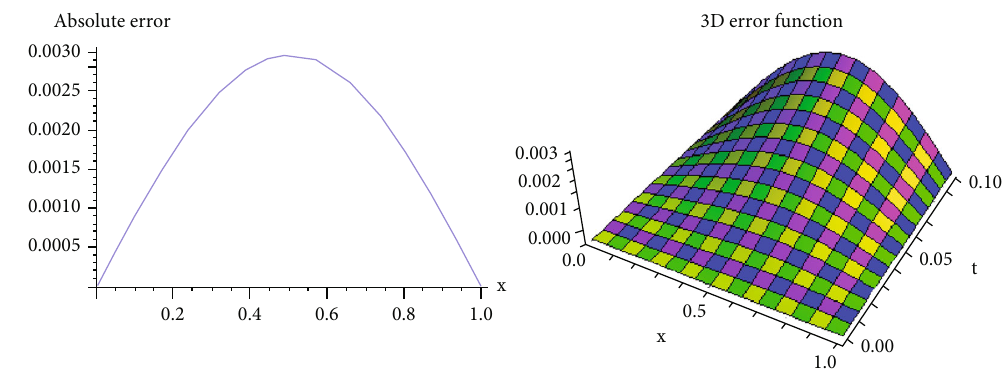
Figure 3: 2D and 3D error pro fi les for Example 5 when h = 1/60, t = 0 : 1, Δ t = 0 : 01